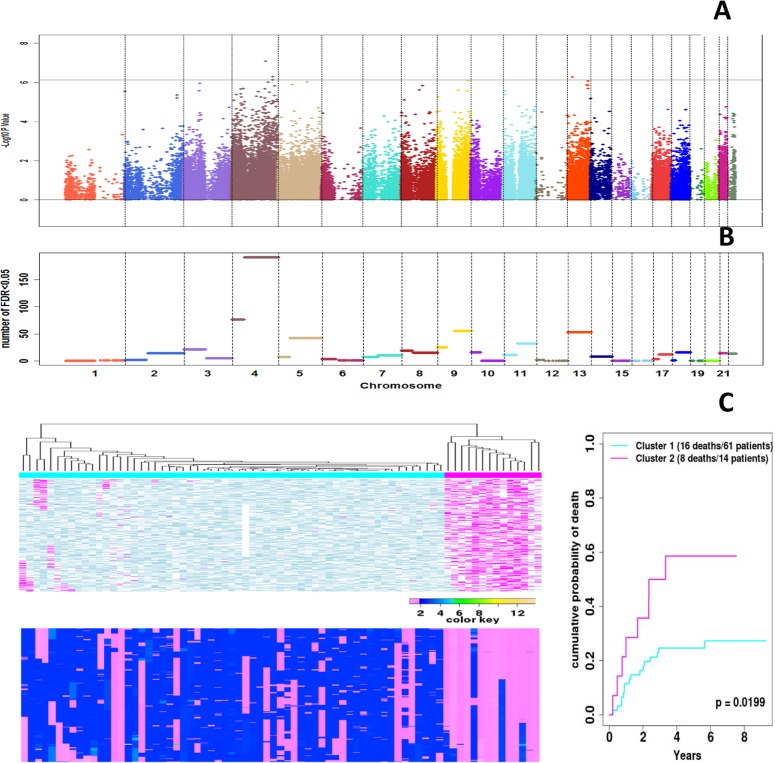
Association of each probe’s LOH status and DNA copy number with OSCC-specific mortality.A) Manhattan plot of p-values for testing the association of each probe’s LOH status and DNA copy number with OSCC-specific mortality. The X-axis shows the genome order with different chromosomes separated by vertical grey lines. The Y-axis shows the negative log10 p-values from likelihood ratio test for testing the main effect and interaction terms for CNV & LOH in the Cox model that also include terms for sex, age, and smoking history. The horizontal grey line corresponds to Bonferroni cutoff 0.05/66875. B) Number of loci in each chromosome arm, whose p-value survived the FDR 0.05 cutoff in A). The X-axis again stands for the genome order. The Y-axis stands for the number of probes (probes from the same chromosome arm share the same value). C) LOH and CNA data for the whole Chr. 4q (8975 probes from nucleotide position from 63637813 to 183550869). The top left panel shows the heatmap of LOH data (magenta, LOH present; blue, no LOH; white, not informative). The bottom left panel shows the heatmap of tumor CN data, and the color key indicates the copy number. In both heatmaps, the rows stand for SNPs and the columns stand for samples. Based on the LOH data, we clustered the samples into two groups (14 patients in the magenta group and 61 patients in the blue group) using hierarchical clustering algorithm. The right panel shows the Cumulative Incidence curves of the OSCC-specific death of the patients in the two clusters. The X-axis indicates the years between surgery and last follow-up or death. And the Y-axis indicates the mortality rate. Survival of the two clusters of patients was significantly different (p = 0.0199) according to log rank test.